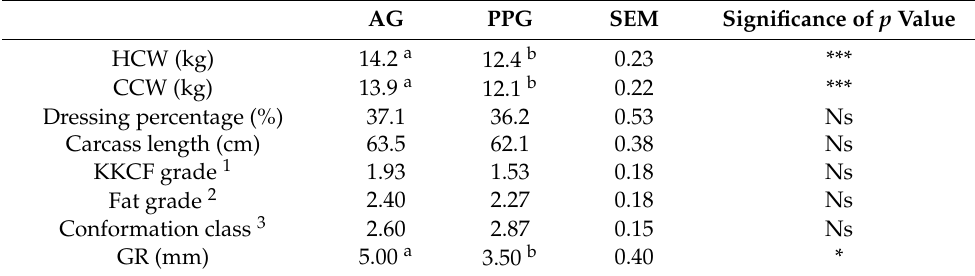
Table 4. Effects of pasture type on lamb carcass characteristics. AG PPG SEM Significance of p Value HCW (kg) 14.2 a 12.4 b 0.23 *** CCW (kg) 13.9 a 12.1 b 0.22 *** Dressing percentage (%) 37.1 36.2 0.53 Ns Carcass length (cm) 63.5 62.1 0.38 Ns KKCF grade 1 1.93 Fat grade 2 2.40 Ns Conformation class 3 2.60 2.87 0.15 Ns GR (mm) 5.00 a 3.50 b 0.40